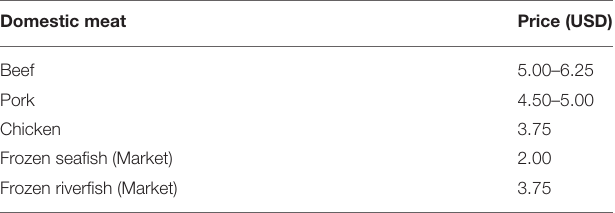
TABLE 2 | Prices of traded domestic meats, brought into the village by traders on motorbikes, from Battambang. Domestic